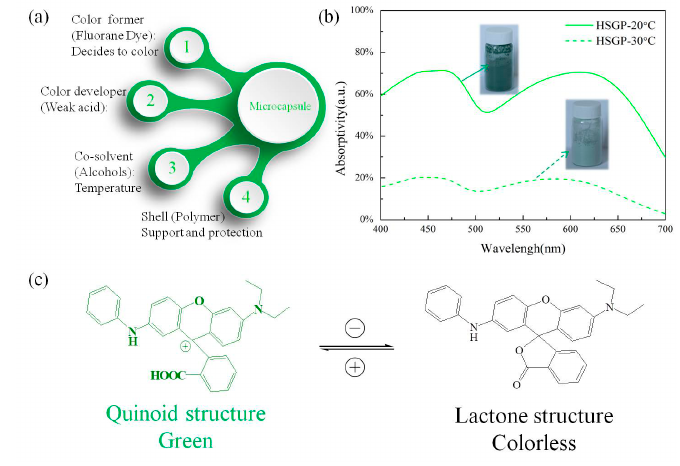
Figure 1. ( a ) Thermochromism of heat-sensitive green TF-G pigment (HSGP); ( b ) The absorption spectra of HSGP at 20 °C and 30 °C; ( c ) Heat-sensitive green TF-G dye with different chemical structures.